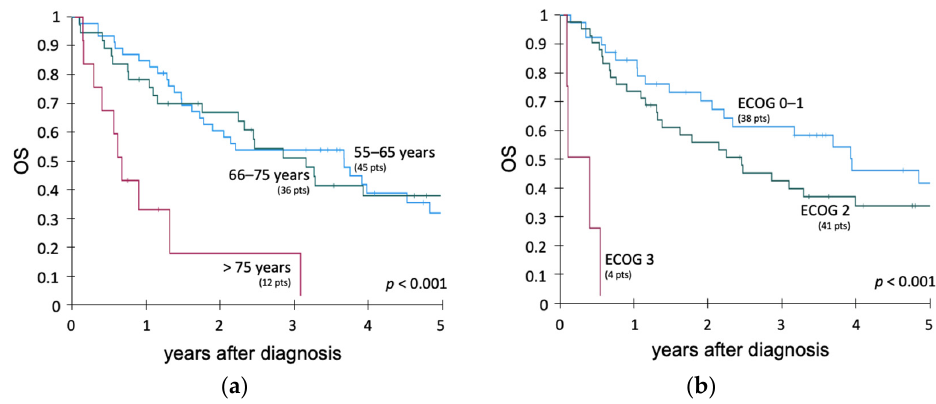
( a ) ( b ) Figure 3. Overall survival of different subgroups of the entire patient cohort of 93 intensively treated patients (88 patients with B-precursor and 5 patients with T-ALL). ( a ) 5-year OS comparing age groups (45 pts 55–65 years, 36 pts 66–75 years, 12 pts > 75 years). ( b ) OS comparing ECOG (38 pts ECOG 0–1, 41 pts ECOG 2, 4 pts ECOG 3; data available for 83 pts). In the univariate Cox proportional hazards model, an ECOG status >2 and older age were associated with lower OS ( p < 0.05) (Table 3). In a multivariate analysis, including variables with a p < 0.2 in univariate analysis, an ECOG status >2 and older age remained significantly associated with inferior OS ( p < 0.05) (Table 3). Table 3. Univariate and multivariate analysis of predictors of survival for 93 patients with B-precursor ALL or T-ALL receiving intensive treatment (1) . Univariate Analysis Multivariate